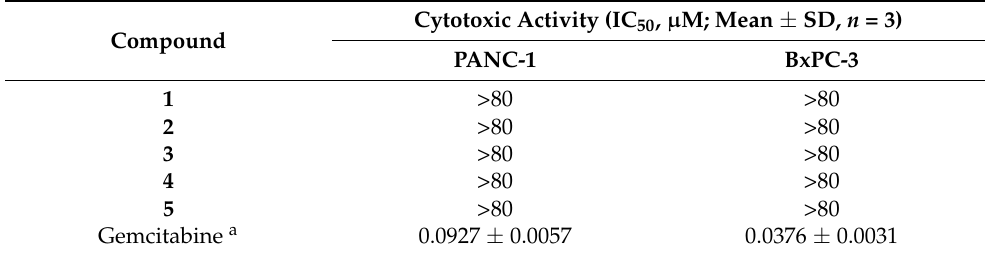
Table 7. Cytotoxic activity of compounds 1 – 5 against human pancreatic cancer cells in vitro (IC 50 , µ M).